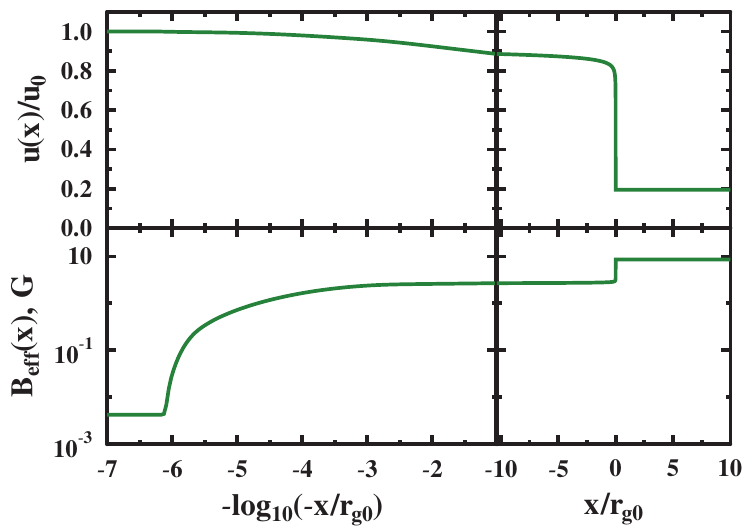
Figure 10. Background plasma velocity profile (upper panel) and magnetic field profile (bottom panel) for the model